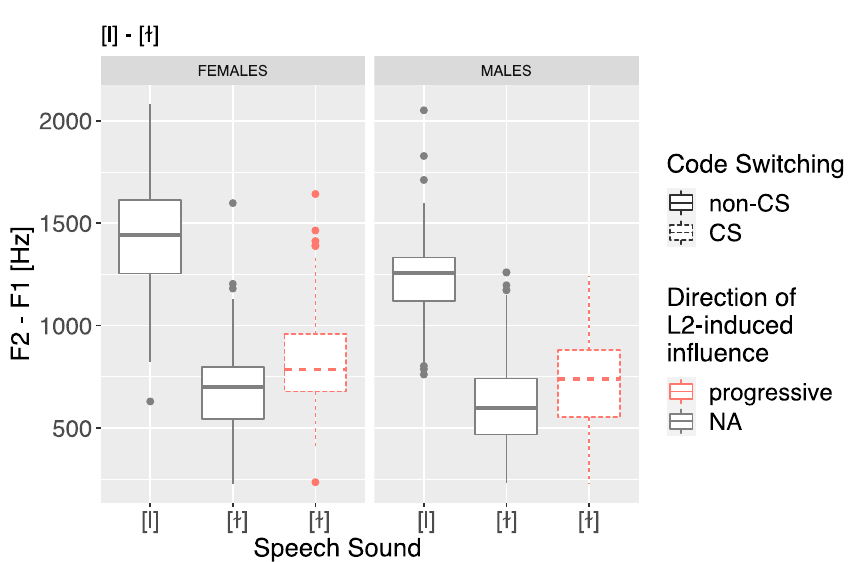
Figure 11. The distance between F1 and F2 of intended [l] and [ ɫ ] sounds in English words, spoken by BIL speakers in non-CS (solid) and CS (dashed) speech; productions in CS environments were only available in progressive (red) L2-induced influence. The left panel shows female data, the right panel male data.